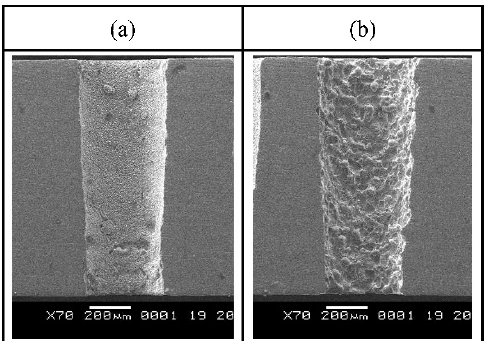
Figure 11. SEM image of the micro hole profile under different spindle rotation speed; ( a ) 1150 rpm ( b ) 4370 rpm.